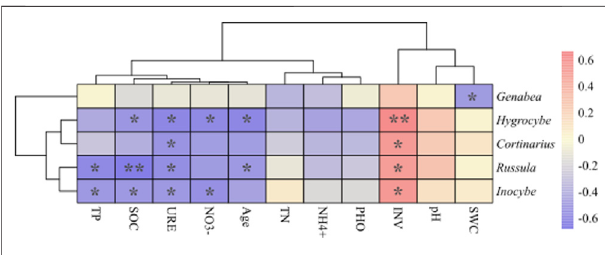
FIGURE 6 | Correction heatmap between soil factors and main EcM fungi. The x-axis and y-axis are environmental factors and the top fi ve genera. The R values and p value of Spearman ’ s rank correlation are obtained by calculation.Rvaluesareshownindifferentcolors;thelegendontheright is the color range of different R values. *: p < 0.05, **: p <